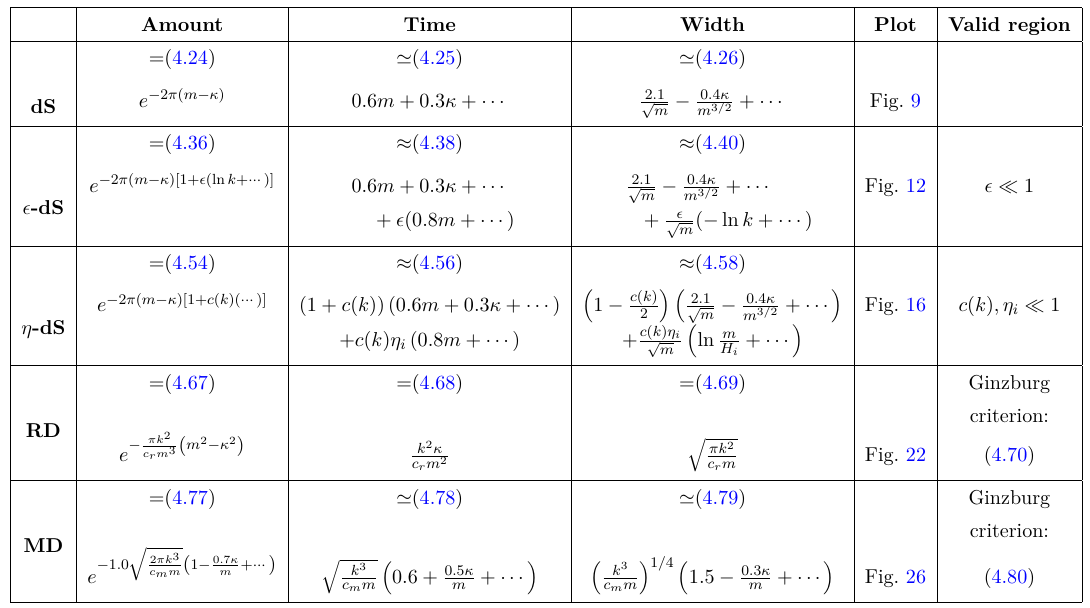
Table 1 . A checklist of results for spin-1 vector bosons. Here RD and MD stand for radiation domination era and matter domination era, respectively. m is the mass while κ is the chemical potential. The = , ’ , ≈ symbols are used to indicate whether the result is exact, numerically exact, or empirical with 2% error. In the schematic expressions, to display the most salient features, we have omitted the Hubble parameter and blurred the difference between m dS. The widths in dS, (cid:15) -type dS and η -type dS are measured in e-folds, whereas the widths in RD and MD are measured in z -domain. The results for spin-1/2 fermion is obtained via a simple replacement rule m 2 → m 2 + κ 2 . Setting κ = 0 also gives the purely gravitational production